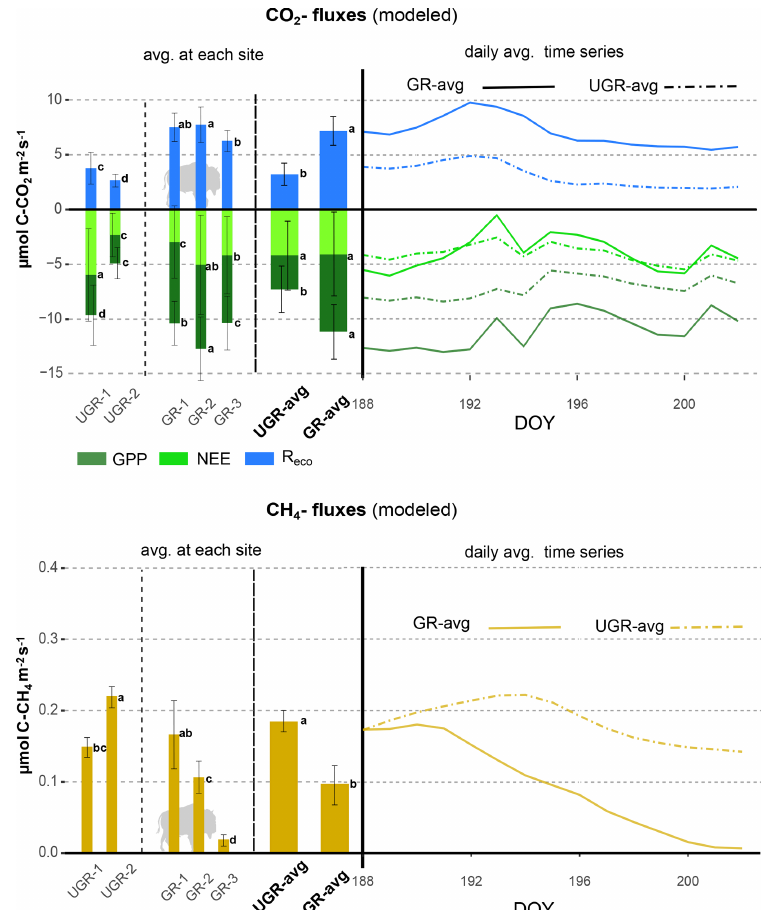
Figure 2. Overview of C fluxes at all chamber plots from 7 to 21 July. Differing letters indicate significant differences between plots ( p < 0 . 01; please also see Table B3 for details). Overall (site average), NEE did not differ significantly between GR and UGR, while GPP and R eco were significantly larger at GR. Daily average CH 4 emissions at grazed plots strongly decrease over time, leading to a substantial net reduction in methane emissions at the GR plots, compared to the UGR